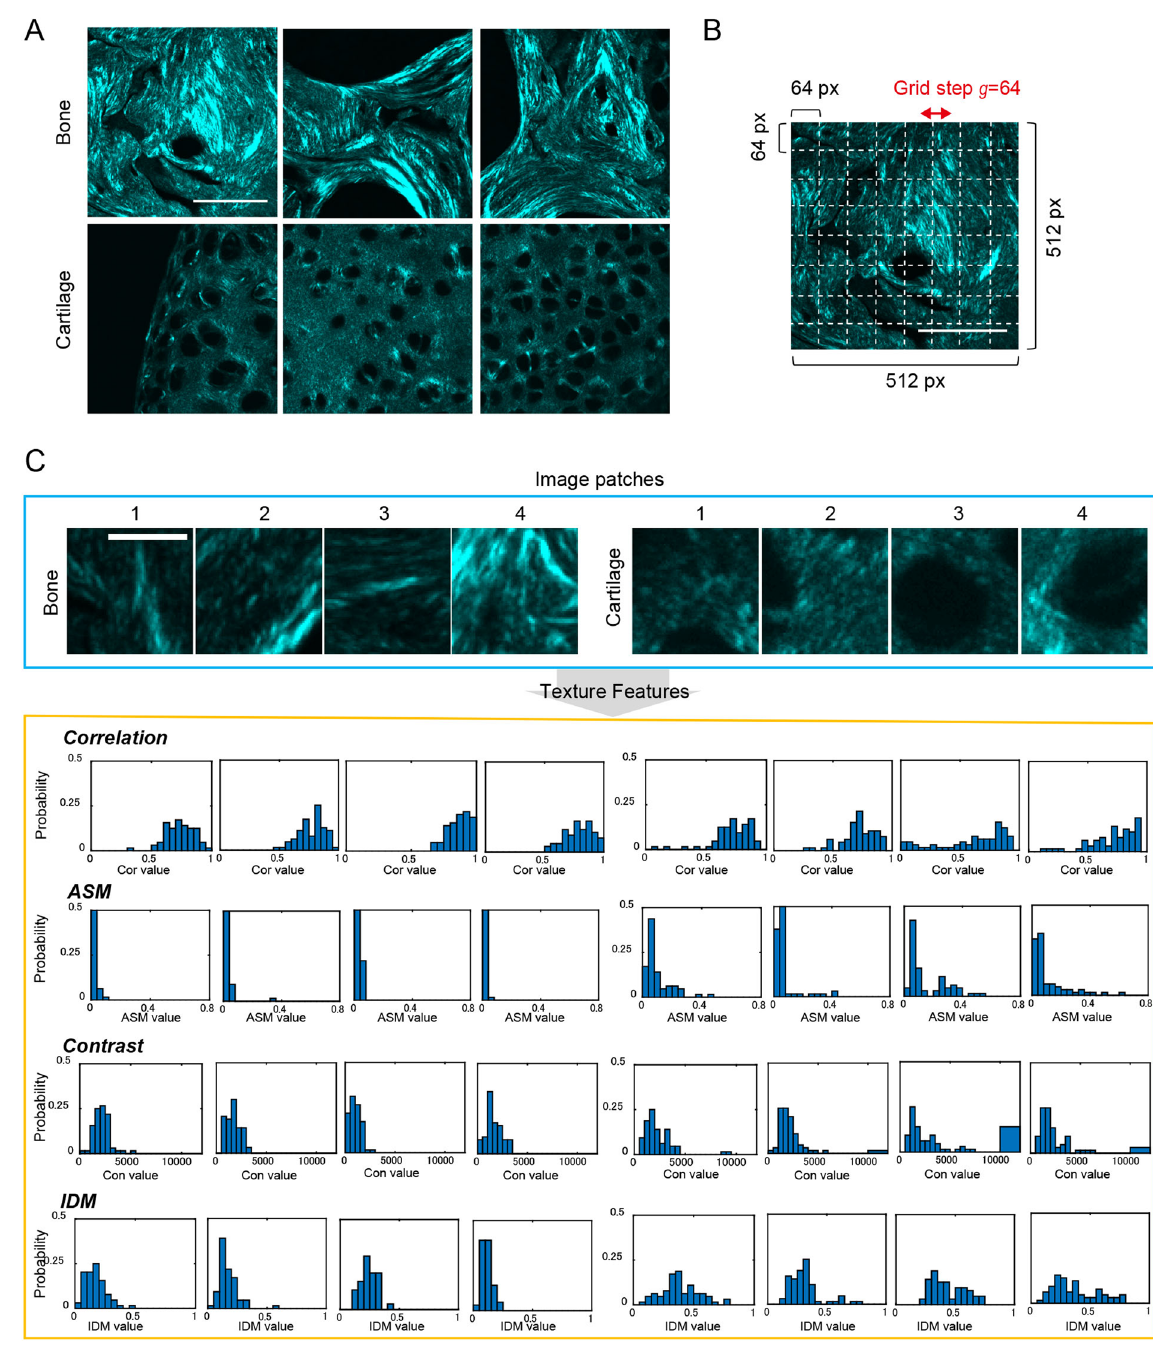
Figure 2. Scheme for texture feature extraction from SHG images. ( A ) Representative images of the subchondral bone (upper) and articular cartilage (lower). Scale bar: 50 μ m. ( B ) Image patches to be subjected to feature vector calculations are selected according to the regular square grid (white dashed lines). This grid is defined by the parameters of the grid step and the image patch size, where the grid step is the distance between neighboring patches. ( C ) Next, the patches are subjected to the texture parameter calculation using the GLCM. Correlation, ASM, contrast, and IDM corresponding to the images presented in ( B ) are shown. Scale bar: 10 μ m. Cor value: Corralation value. Con value: Contrast